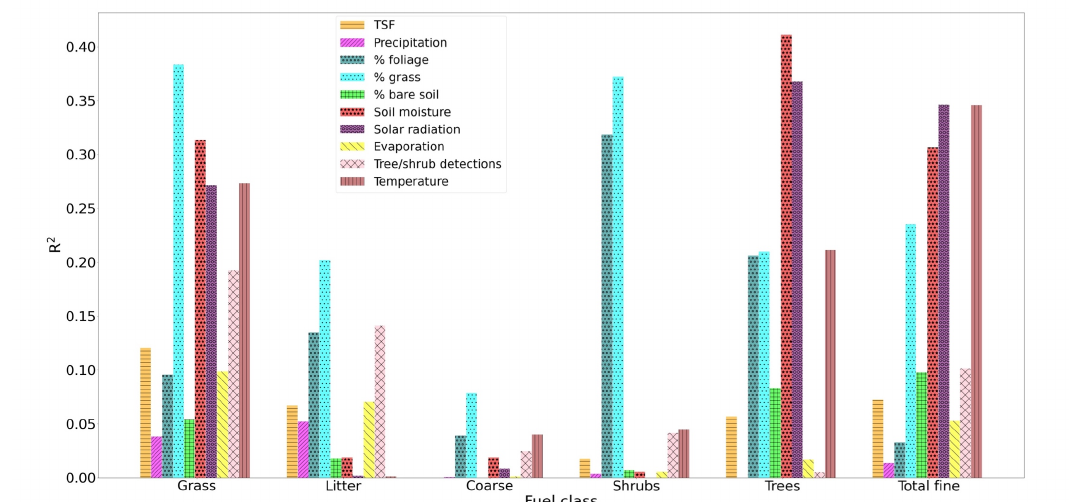
Figure 11. The explained variance of measured AGB due to each feature used in the model. TSF: Time Since